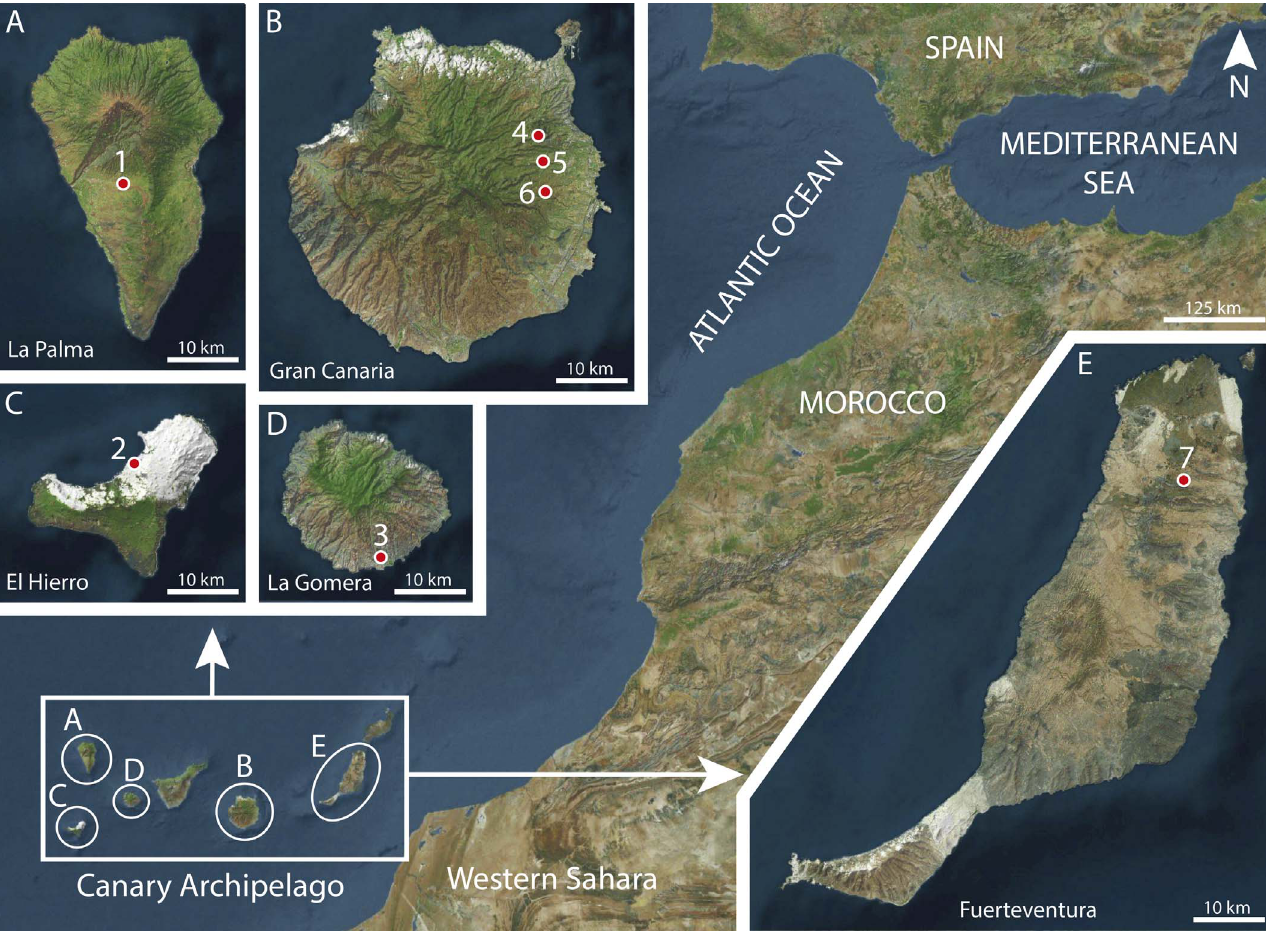
Figure 1. Localities where Mus musculus parasitized by Pterygodermatites ( Mesopectines ) valladaresi n. sp. were captured on the islands of La Palma, El Hierro, La Gomera, Gran Canaria and Fuerteventura. 1, El Paso; 2, Lagartario-Frontera; 3, Gasolinera-Antocojo; 4, La Barrera; 5, Lomo del Conde; 6, Pasadilla; 7, La Oliva (type